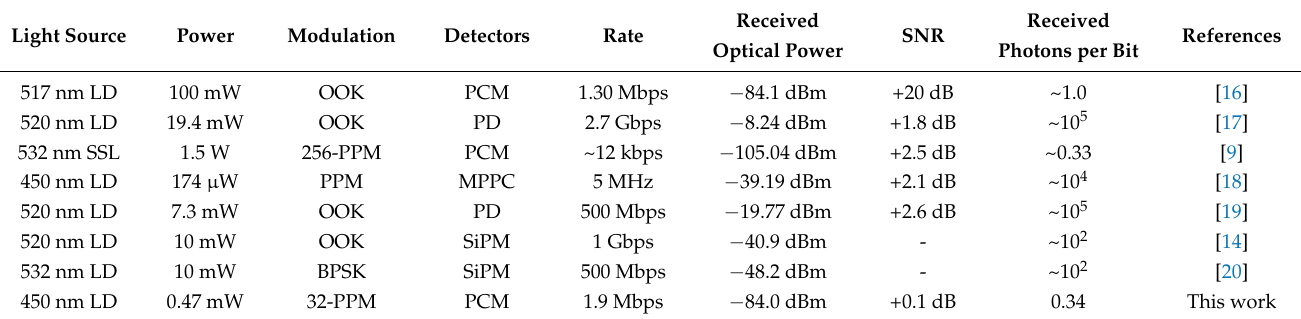
Table 1. Comparison of the published UWOC